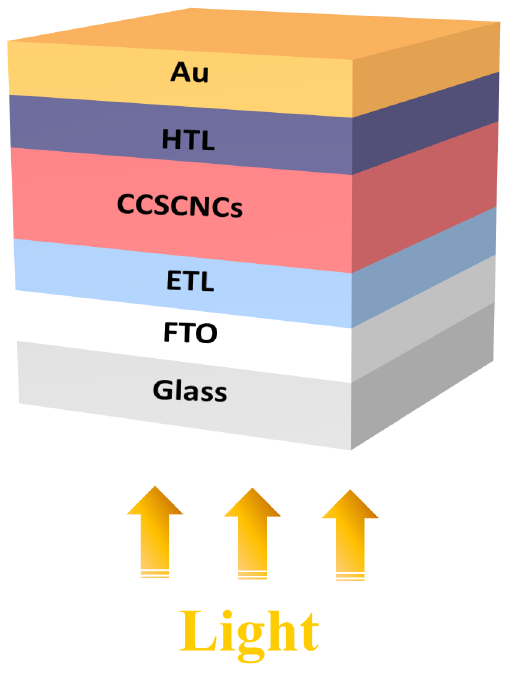
Figure 1. Schematic of the CCSCNCs-based perovskite solar cell. Table 2. Input parameters for ETL of the PSC structure. Table 1. Input parameters for CCSCNCs absorber layer and HTL of the PSC structure.